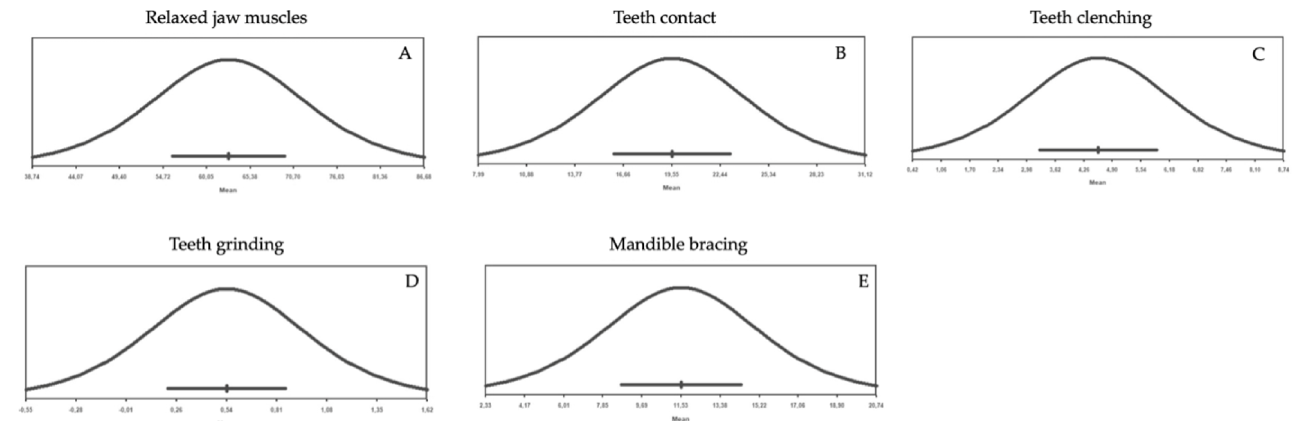
Figure 3. ( A – E ) Reported frequency data of AB behaviors (e.g., relaxed jaw muscles, teeth contact, teeth clenching, teeth grinding, mandible bracing).